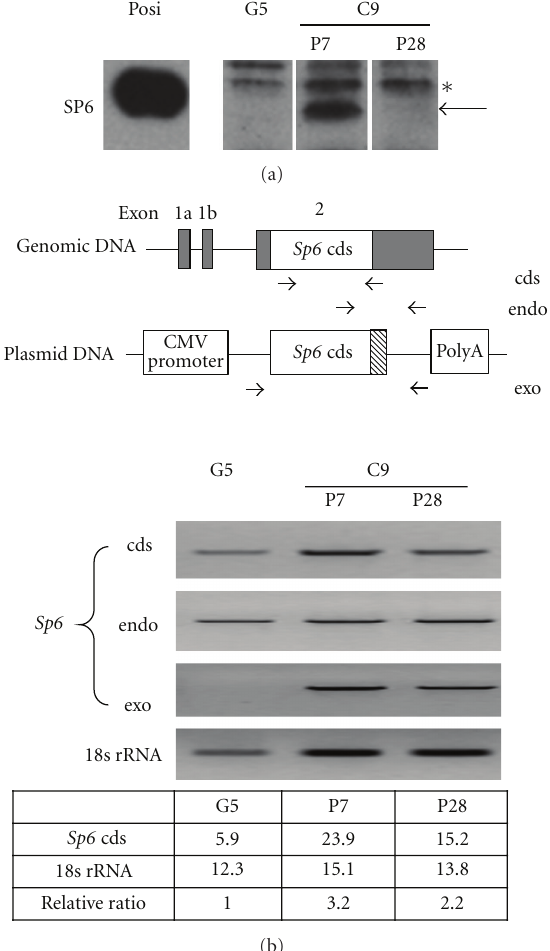
Figure 1: Downregulation of SP6 in C9 cells during long-term culture. (a) SP6 expression in C9 cells (P7 and P28) and in parent G5 cells. SP6 protein levels were analysed by WB using anti- HA antibody. Arrow: SP6 ; asterisk: nonspecific band and Posi: positive control. (b) Sp6 mRNA expression in C9 cells (P7 and P28) and G5 cells. Upper panel indicates schematic structure of the Sp6 gene and expression plasmid together with primer positions. Primers designed to detect three distinct types of Sp6 mRNA. Arrows indicate each primer’s position and direction. Grey box: untranslated region; striped box: HA-tag; cds: coding region of Sp6 ; endo: endogenous Sp6 ; exo: exogenous Sp6 . Middle panel shows the representative result of RT-PCR analysis. Lower panel shows densitometric analysis data of RT-PCR. Each Sp6 level was normalized by 18S rRNA level, and the relative ratio was calculated compared to that of G5 cells. The level of G5 cells was assigned as